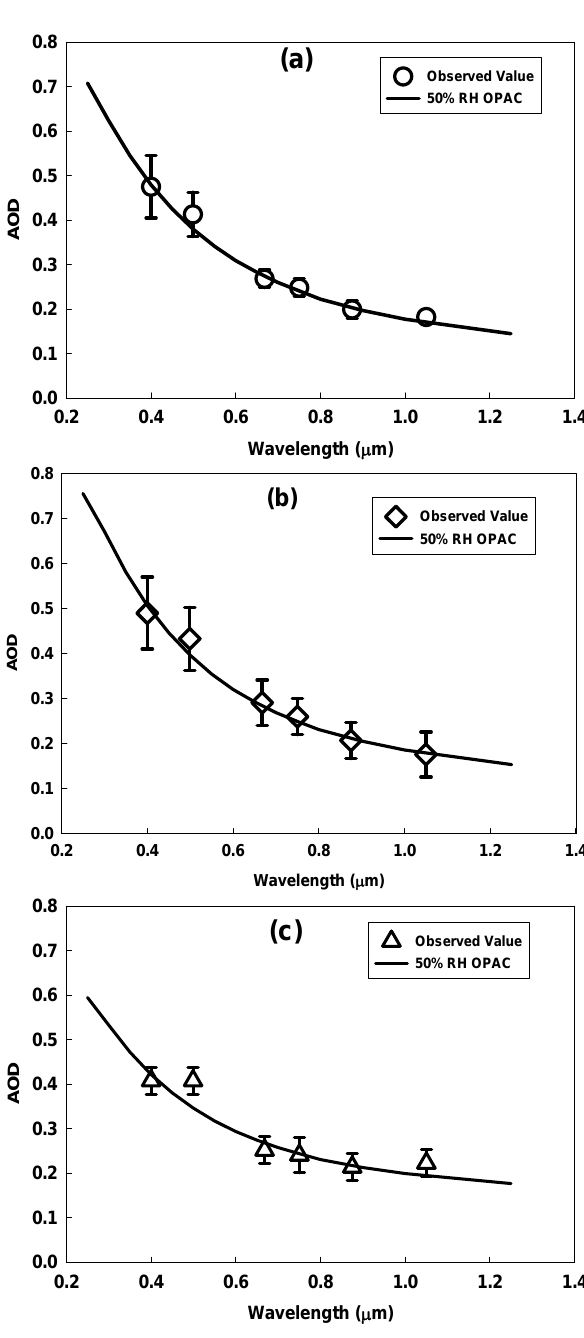
Fig. 6. Average aerosol optical depth spectra obtained on 8, 13 and Figure 6 27 December are fitted with OPAC model